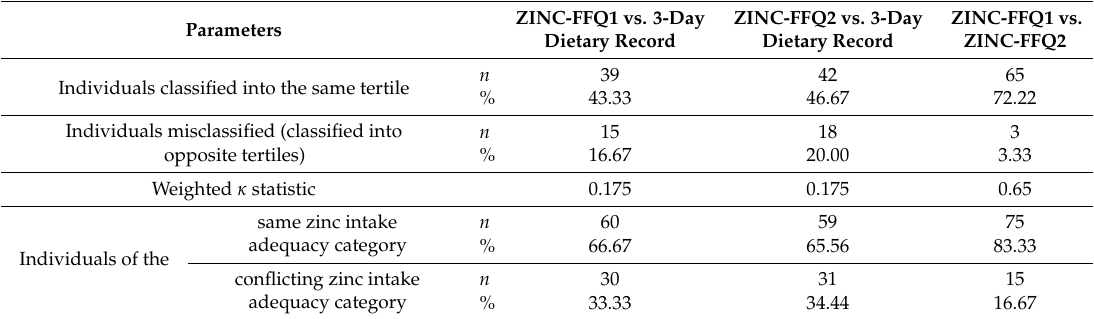
Table 4. The validation of the ZINC-FFQ including tertiles distribution, weighted κ statistic and adequacy